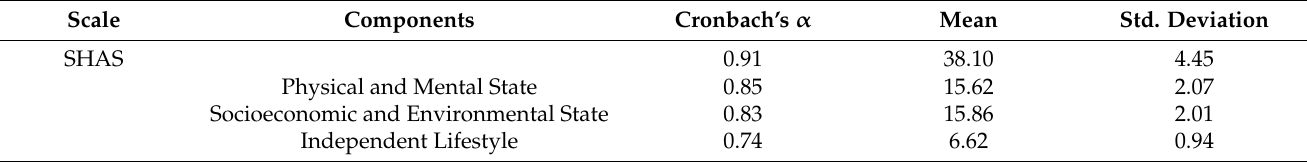
Table 4. Reliability analysis using Cronbach’s α , M, and